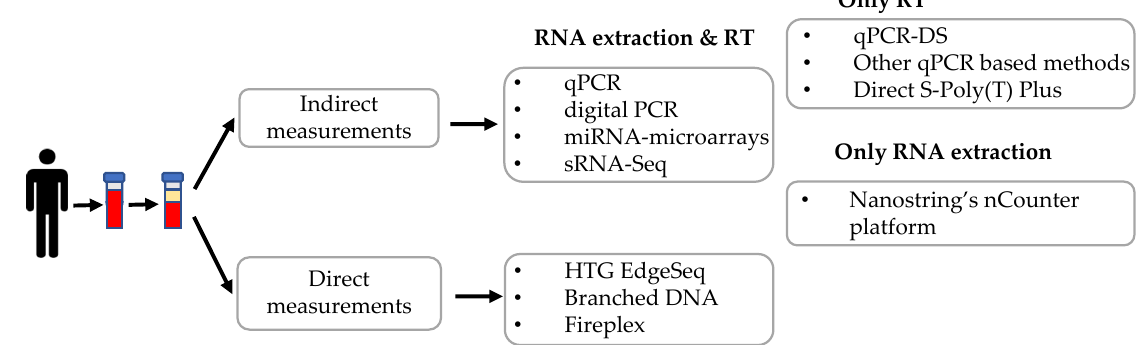
Figure 2. Graphical summary of the different techniques described in this review. RT: Reverse